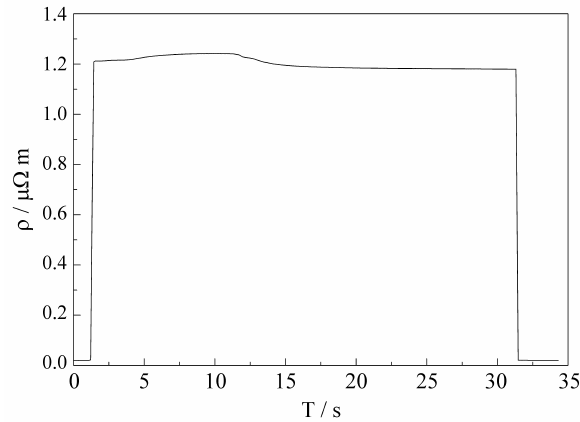
Figure 3. Resistance change vs. time for a flash annealing treatment performed in a sample. The resistance bump is due to crystallization of the